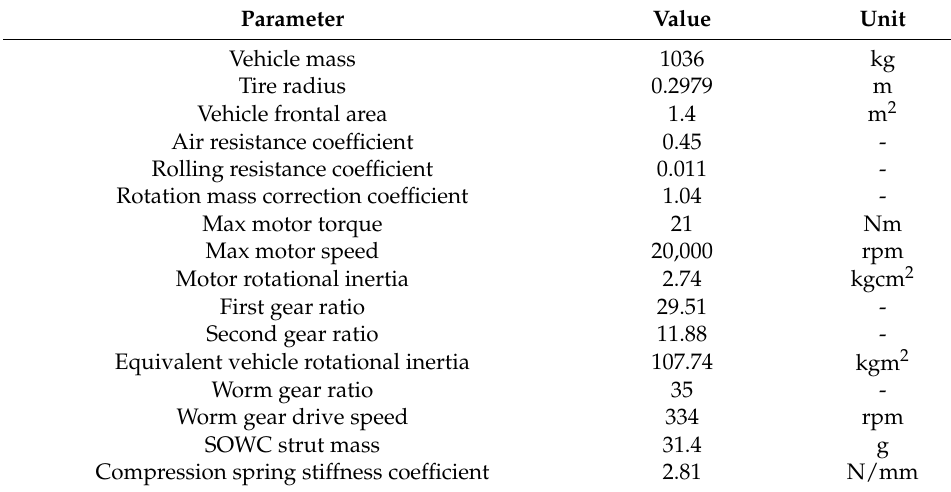
Figure 10. Virtual prototype simulation model of IW-AMT. Table 3. Main parameters of the simulation